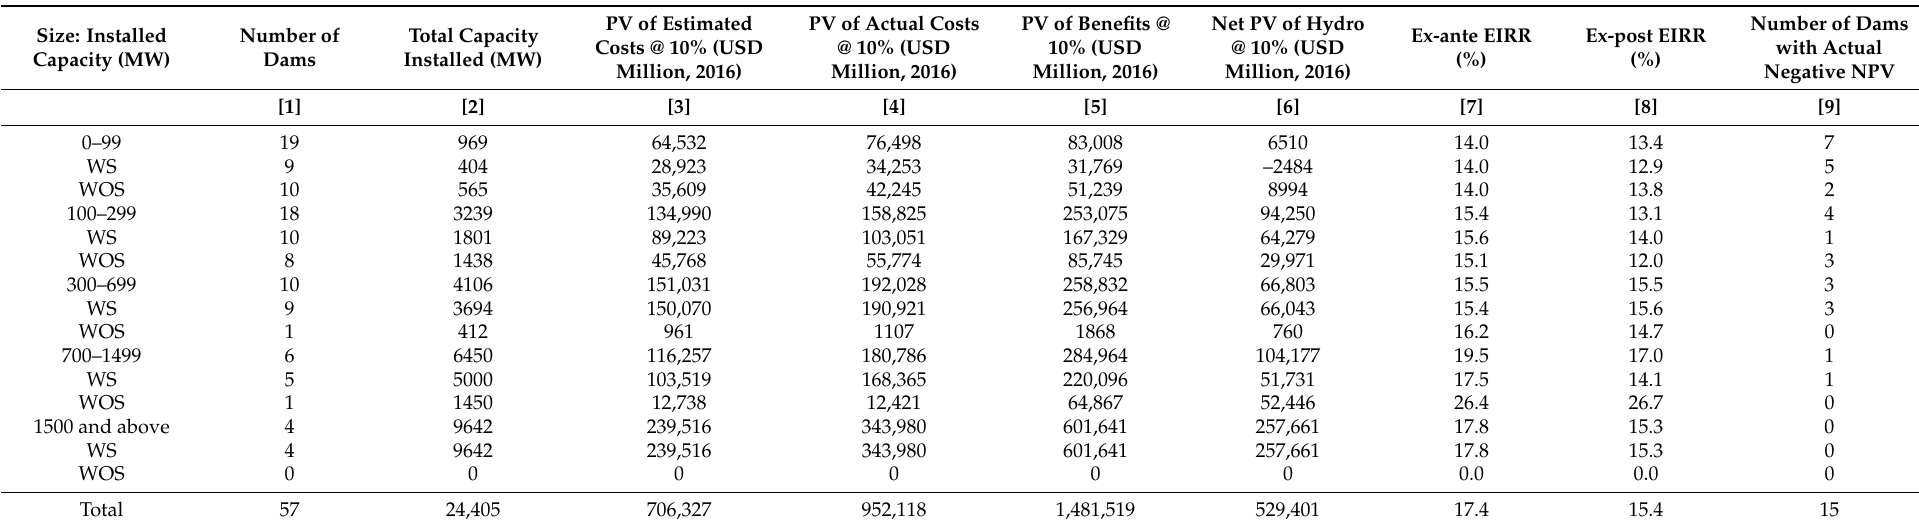
Table 12. Estimated vs. actual EIRR according to size of installed capacity (MW).